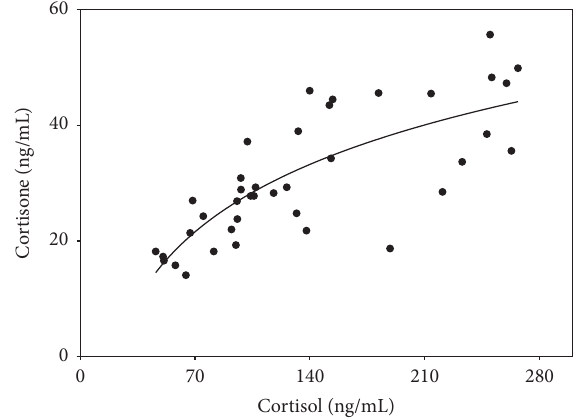
Figure 3: Comparison of the concentration levels between serum cortisol and cortisone collected between 9:00 and